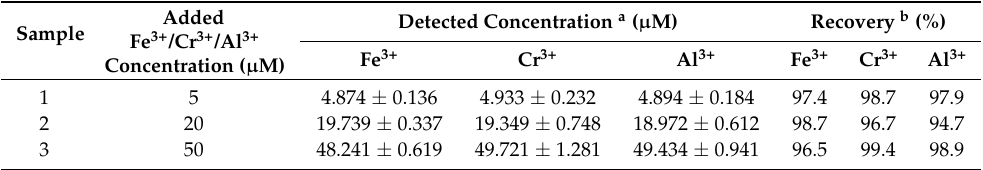
Table 2. Determination of Fe 3+ /Cr 3+ /Al 3+ ions in sample.